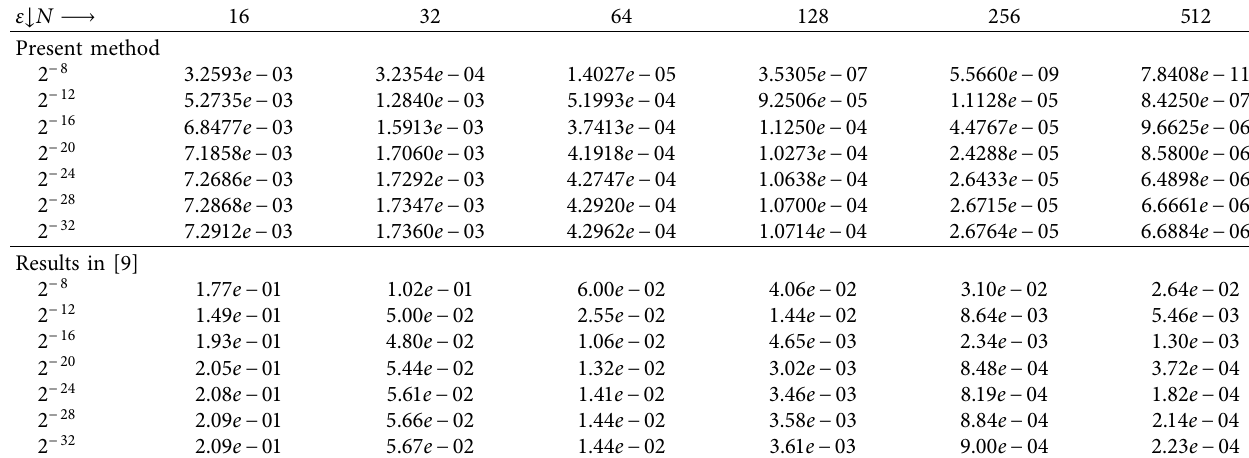
Table 1: Comparison of maximum absolute errors for Example 1.